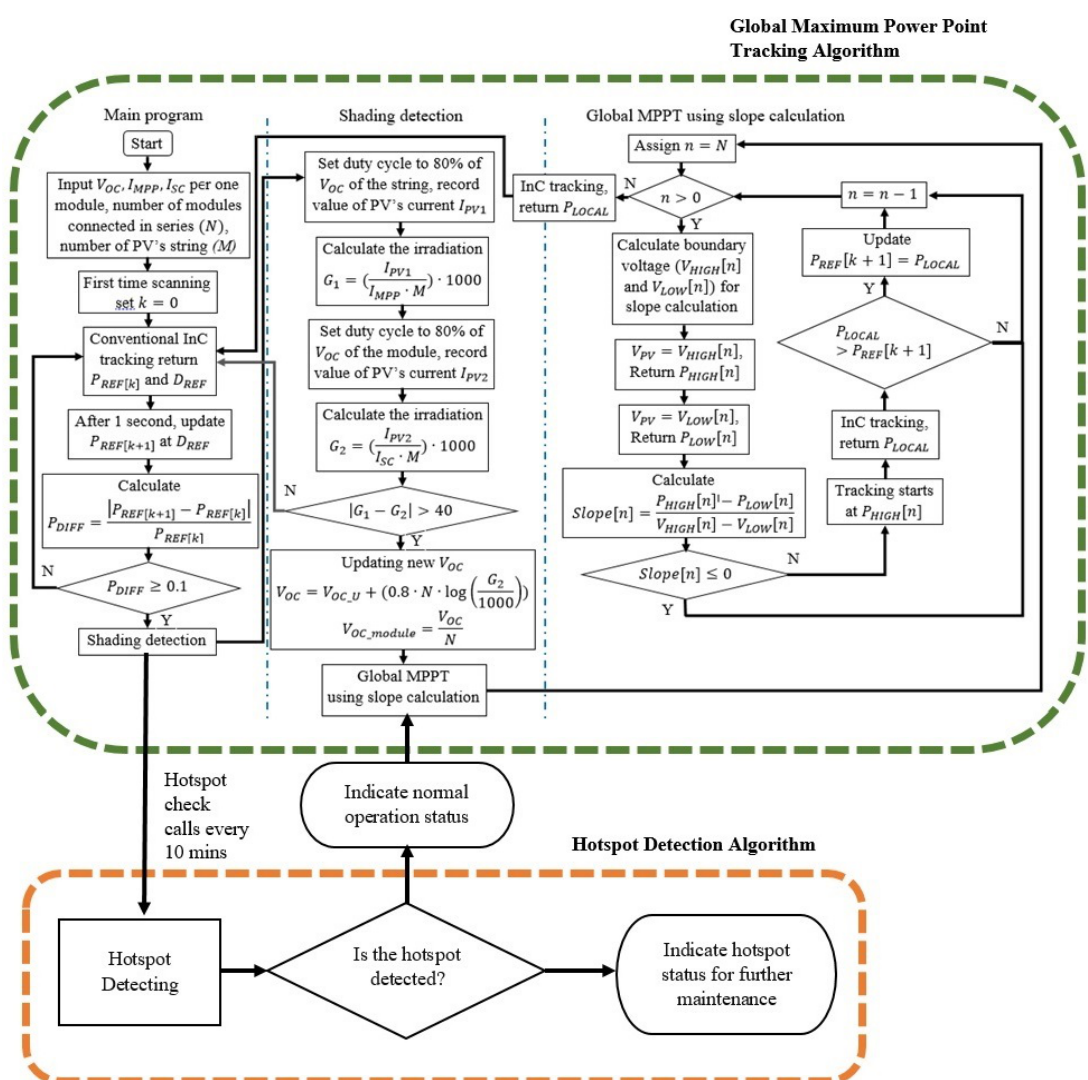
Figure 9. Flowchart of proposed Global MPPT